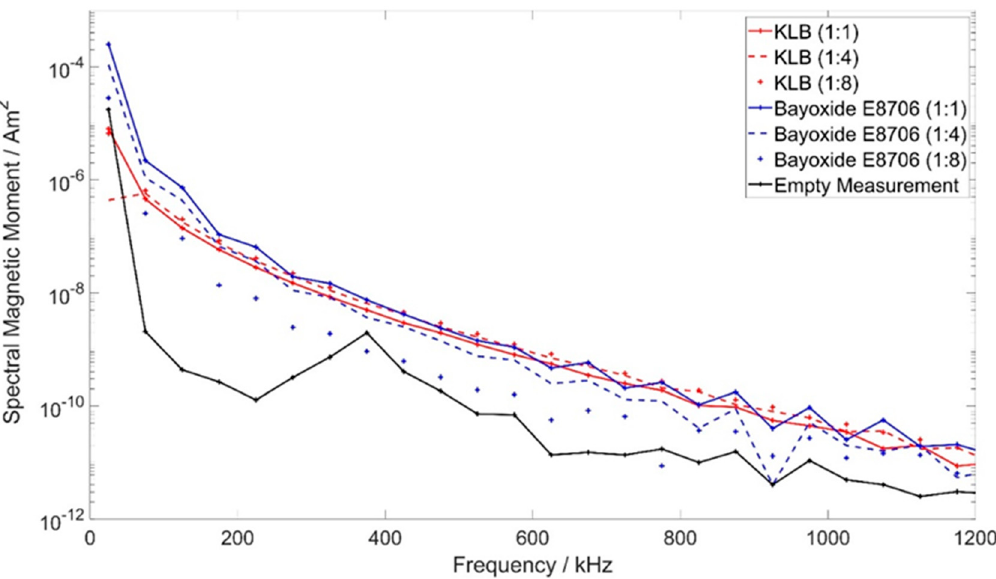
Figure 2. MPS measurements of KLB and Bayoxide E8706 particle coatings.